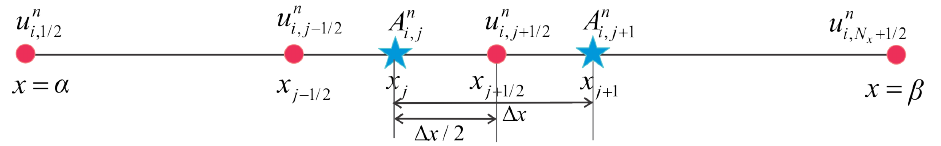
Figure 2. Sketch of the computational domain α ≤ x ≤ β with the staggered grid partition and locations of the computed variables A n